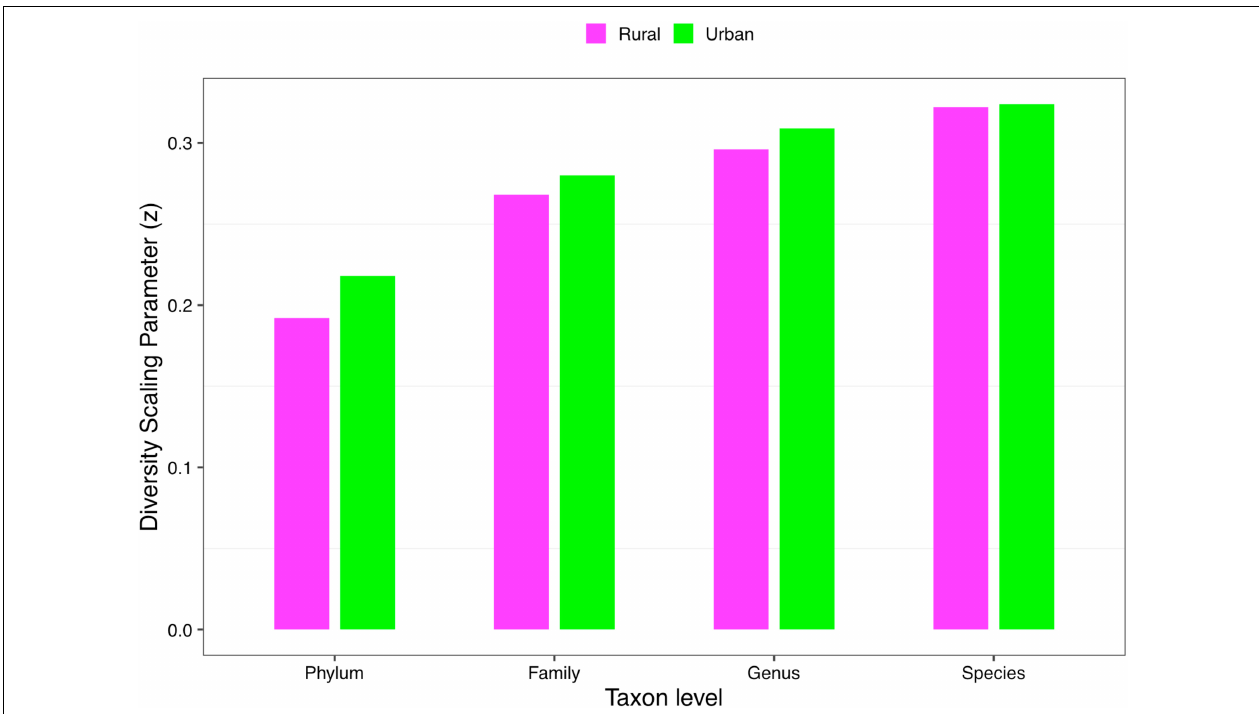
FIGURE 2 | The DAR profiles of the rural and urban cohorts at phylum, family, genus, and species levels when diversity order q = 0 (Scheme 1A).